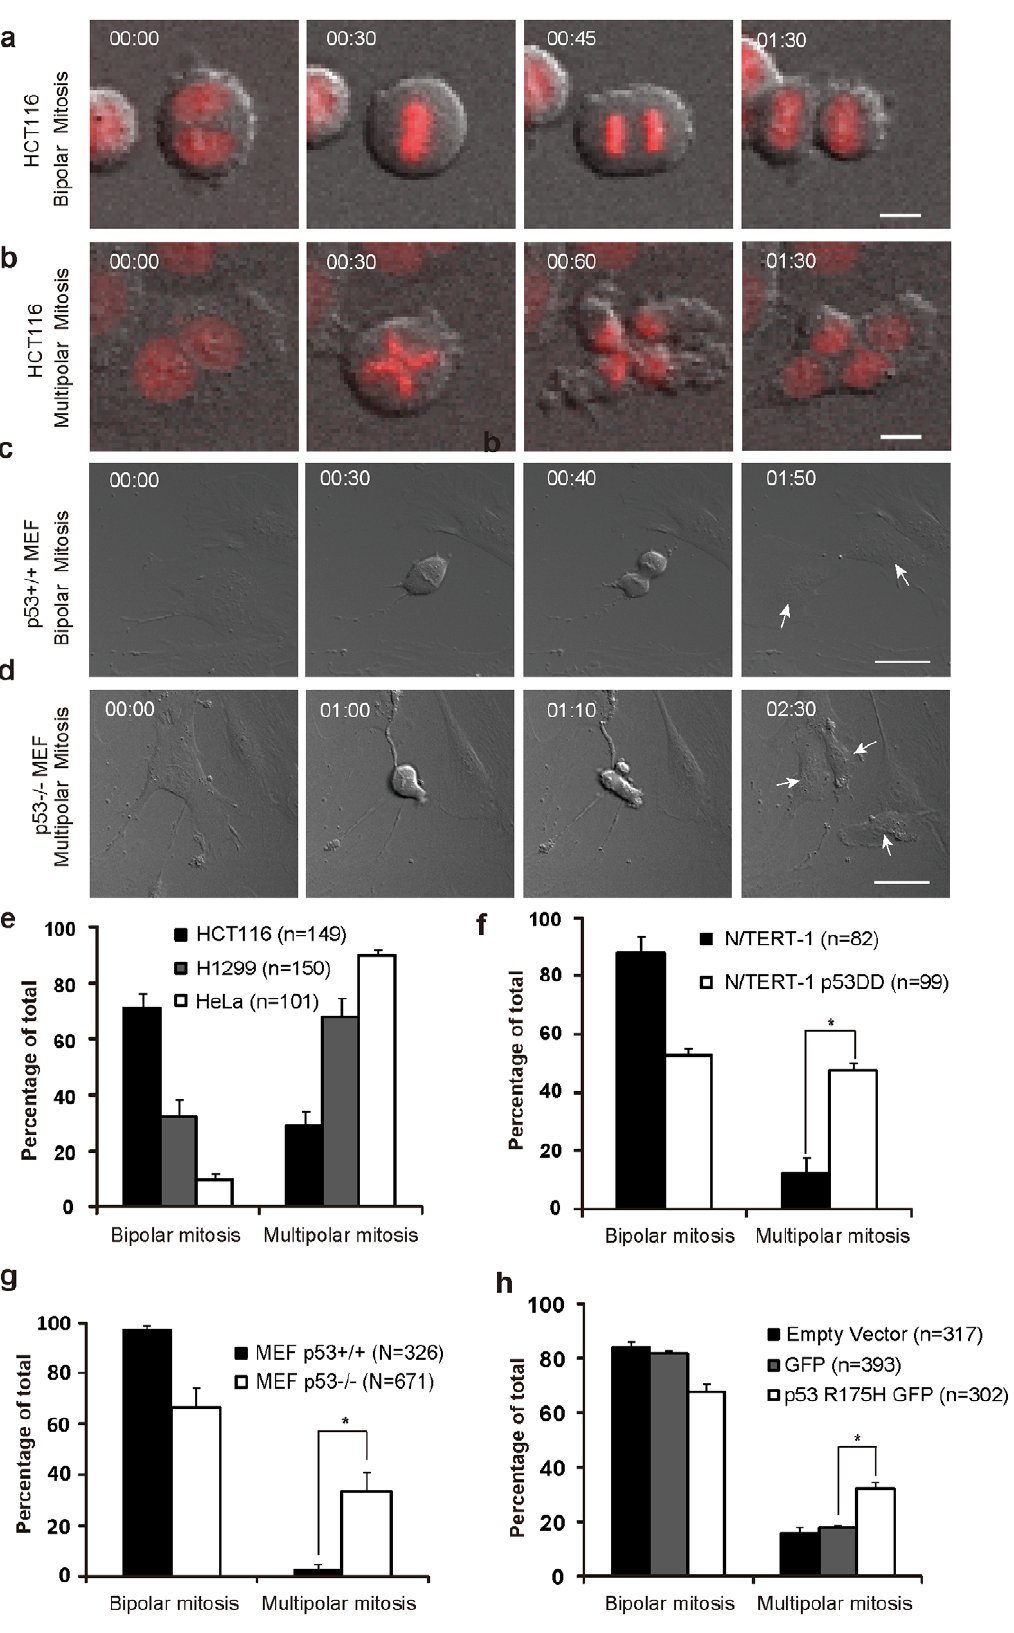
Figure 2. Loss function of p53 promotes multipolar mitosis in tetraploid cells. (A-D) Selected serial images from time-lapse records showing examples of: (A) Bipolar mitosis of a tetraploid HCT116 cell; (B) Multipolar mitosis of a tetraploid HCT116 cell; Chromosomal material is